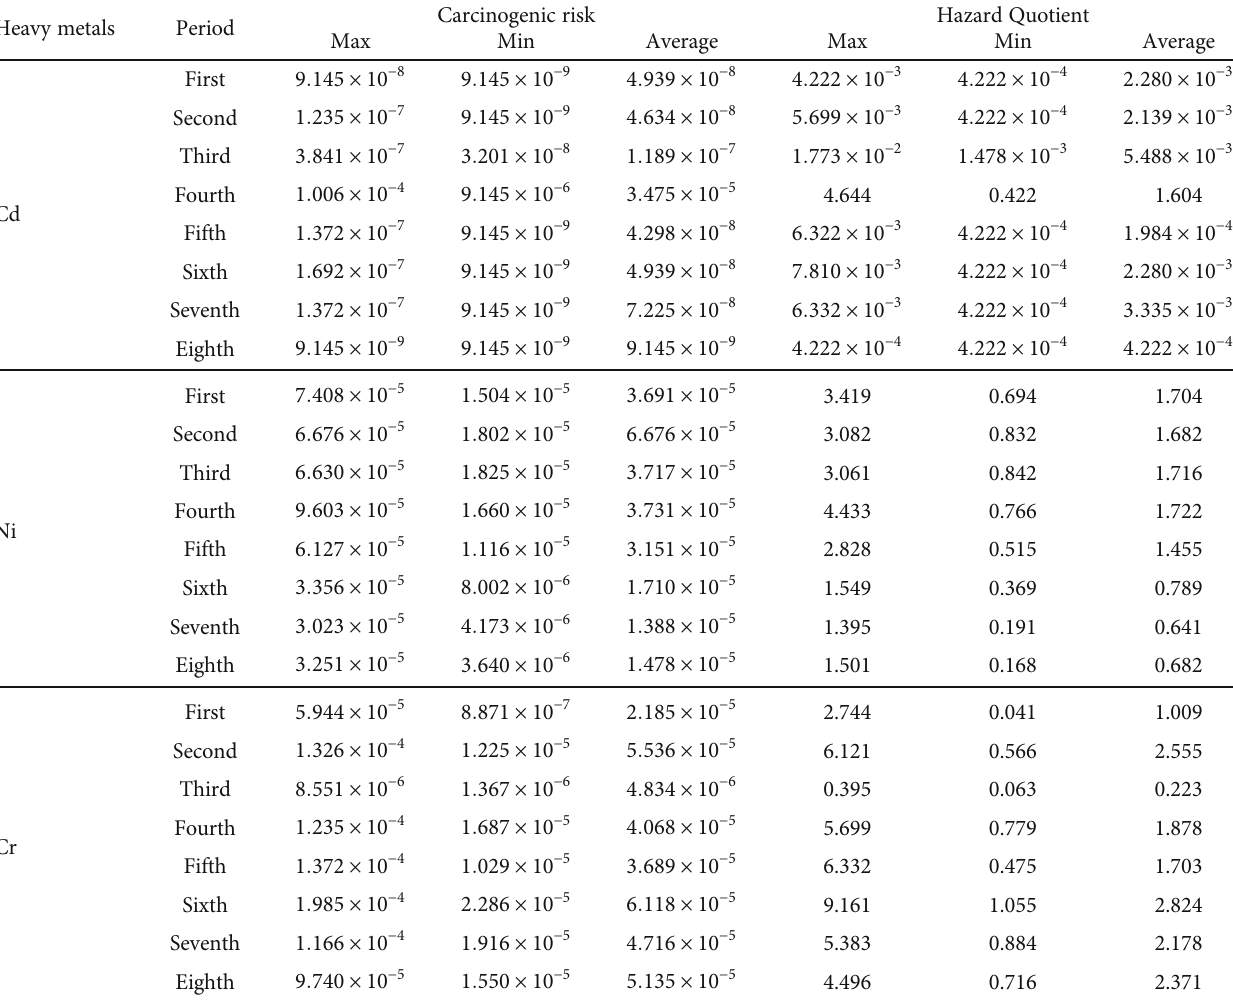
Table 4: The carcinogenic risks and HQs of Cd, Ni, and Cr in di ff erent